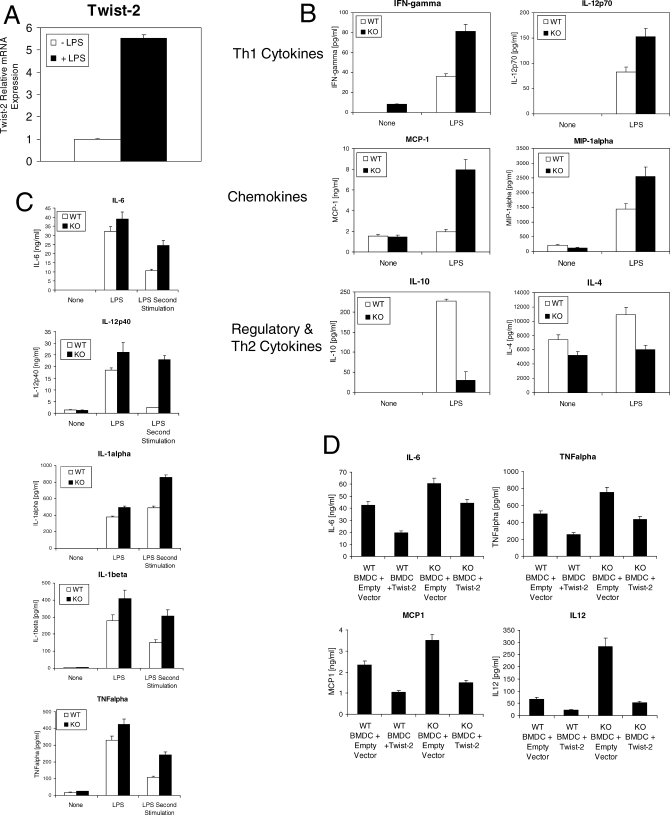
Twist-2 Differentially Regulates the Production of Pro- and Anti-Inflammatory Cytokines by Myeloid Cells(A) Induced expression of Twist-2 mRNA in CD11c+ BM DCs after 4 h of stimulation of LPS (100 ng/ml), as demonstrated by quantitative RT-PCR. Data are normalized to 18S rRNA internal controls, with samples loaded in triplicate from repeated experiments.(B) Representative cytokine production by Twist-2 KO and WT DCs after 24 h of stimulation with 100 ng/ml LPS. Data, presented as mean ± SD, are representative of three independent experiments.(C) Endotoxin tolerance assays. DCs were pretreated with 100 ng/ml LPS for 24 h, washed twice in complete medium, and then allowed to rest for 2 h, and then restimulated with 100 ng/ml LPS for an additional 24 h, after which the culture supernatant was collected and assayed. Data are representative of three independent experiments.(D) Representative cytokine production by WT BMDC and Twist-2 KO BMDC transfected with either empty vector control or Twist-2 expression vector. Cells were then stimulated with 100 ng/ml LPS for 24 h. Data presented as mean ± SD are representative of two independent experiments.